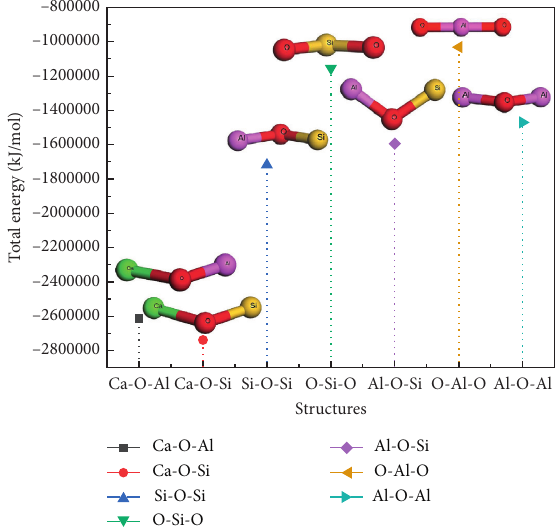
Figure 2: Structural diagram showing total energy of Ca-O-Al, Ca- O-Si, Si-O-Si, O-Si-O, Al-O-Si, O-Al-O, and Al-O-Al.